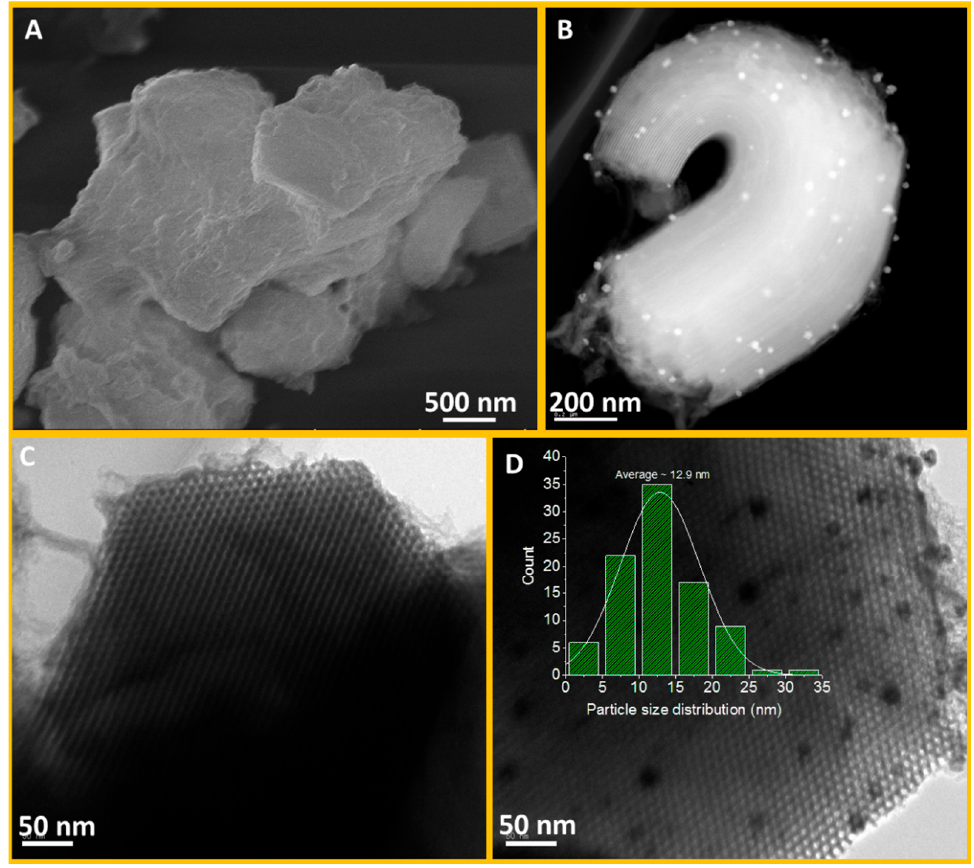
Figure 4. ( A ) SEM and ( B ) HAADF-STEM images of Pd@MO-ISO. TEM images of ( C ) MO-ISO and ( D ) Pd@MO-ISO. Inset indicates the pore size distribution of Pd nanoparticles measured by HAADF-STEM and TEM images.